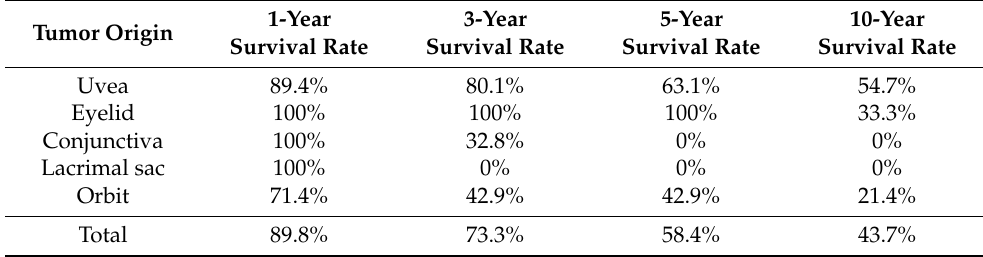
Figure 1. Kaplan–Meier estimate of melanoma-specific survival in patients with primary ocular melanoma. ( A ) Melanoma- specific survival probability. ( B ) Melanoma-specific survival probability in the subgroups with melanoma of specific origins. Table 4. The 1-, 3-, 5-, and 10-year melanoma-specific survival of primary ocular melanoma.